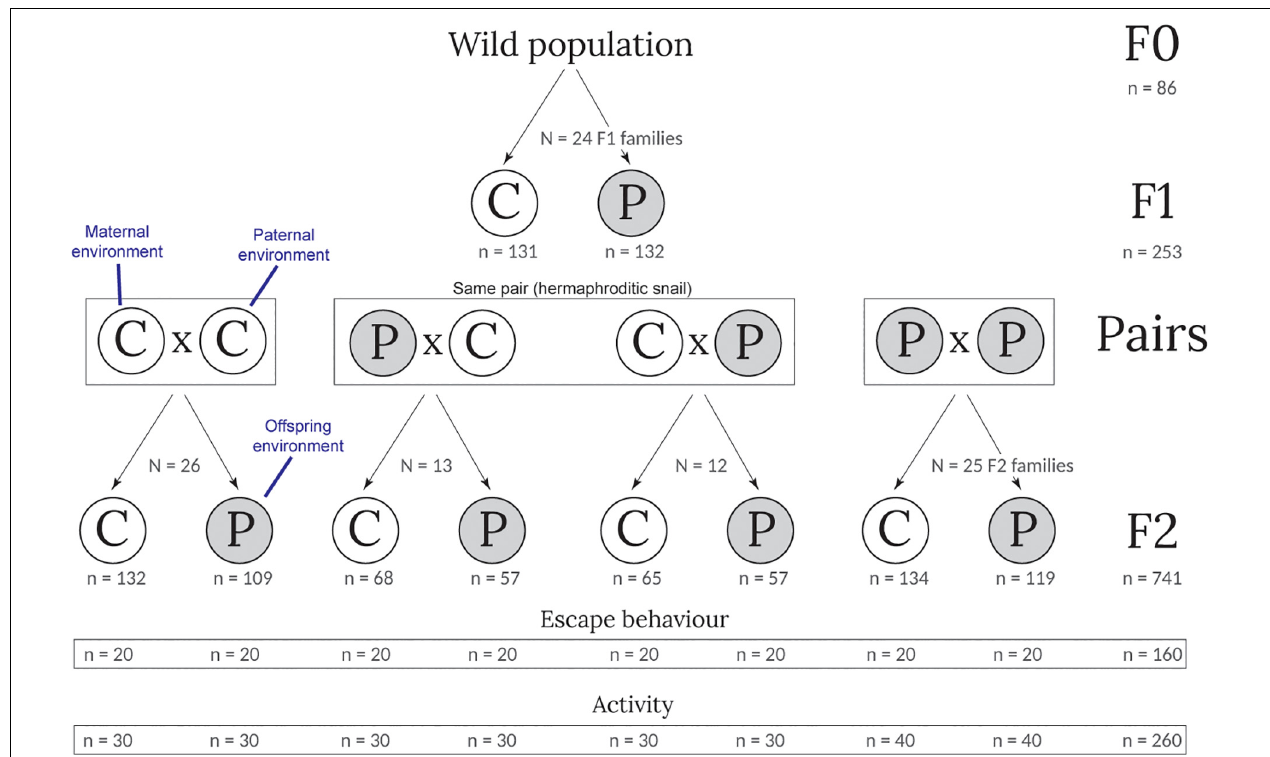
FIGURE 1 | Full factorial design to disentangle the effects of maternal, paternal, developmental and immediate exposures to predator cues on anti-predator behaviors. F1 (maternal and paternal) generation were reared in two developmental environments (“C” stands for control and “P” for predator-cue environment). Then four combinations of maternal x paternal environments (CxC, CxP, PxC, and PxP) were realized. Finally, F2 (offspring) generation were reared in the same two developmental environments. Number of families (N) and number of individuals (n) are indicated, including number of individuals used for behavioral